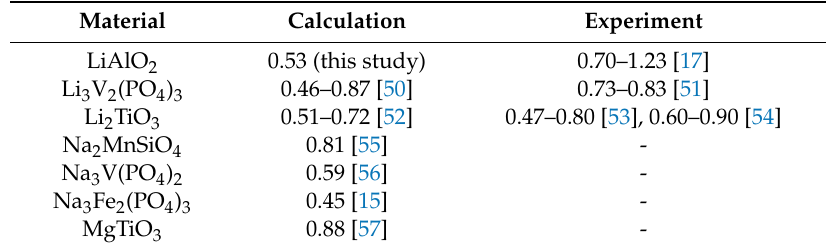
Table 2. Activation energies (eV) of ion self-di ff usion (Li, Na, Mg) in recently investigated oxides considered for battery applications.